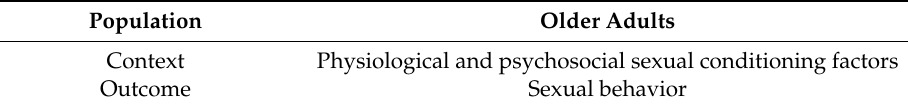
Table 2. Population, Context and Outcome (PCO) framework of our